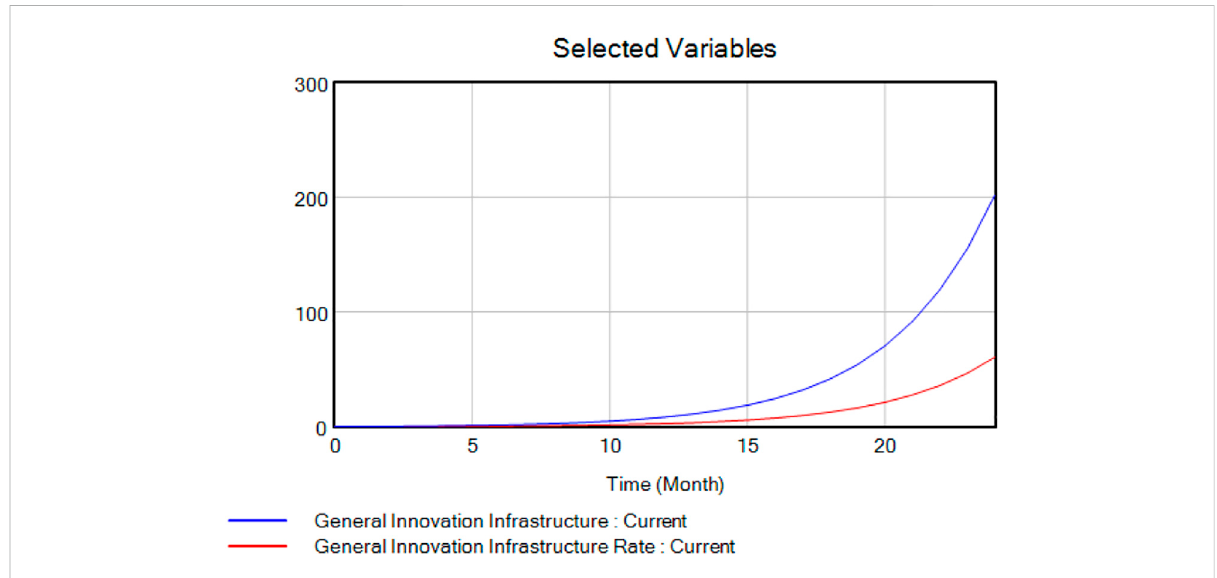
FIGURE 6 Causal strip diagram variable general innovation infrastructure source: Data processing results,